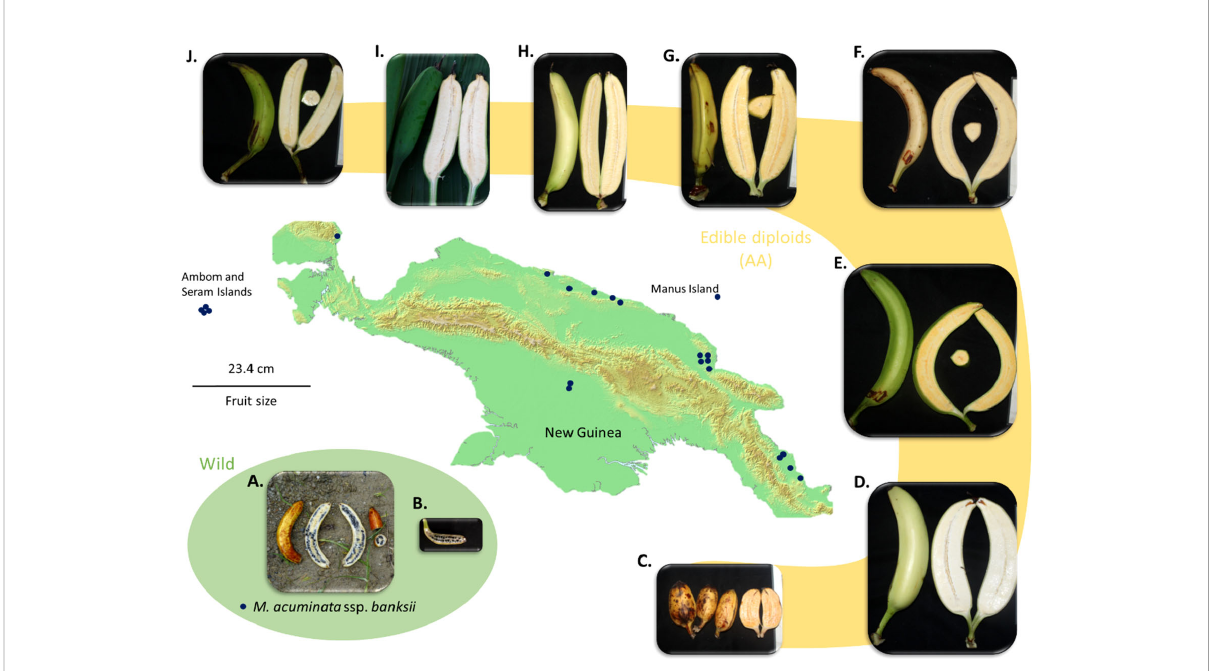
FIGURE 4 Map of New Guinea Island and examples of fruits of M. acuminata ssp. banksii (A, B) and of closely related cultivated AA accessions from Papua New Guinea (C) . AROB003 ‘ Mero Mero ’ , (D) AROB034 ‘ Nesuri ’ , (E) AROB004 ‘ Wiau ’ , (F) AROB035 ‘ Talasea ’ , (G) AROB050 ‘ Seseve ’ , (H) AROB047 ‘ Tobaung ’ , (I) AROB019 ‘ Tavilo ’ , and (J) AROB016 ‘ Nape ’ e ’ ). Dark blue dots on the map represent collection locations for accessions within the cluster ‘ banksii ’ (according to Sharrock 1988; Sharrock et al., 1988; Sharrock et al., 1989, Sharrock 1989 and Sutanto et al., 2016). Photos: (A, B) taken by fi rst author, (C-J) courtesy of